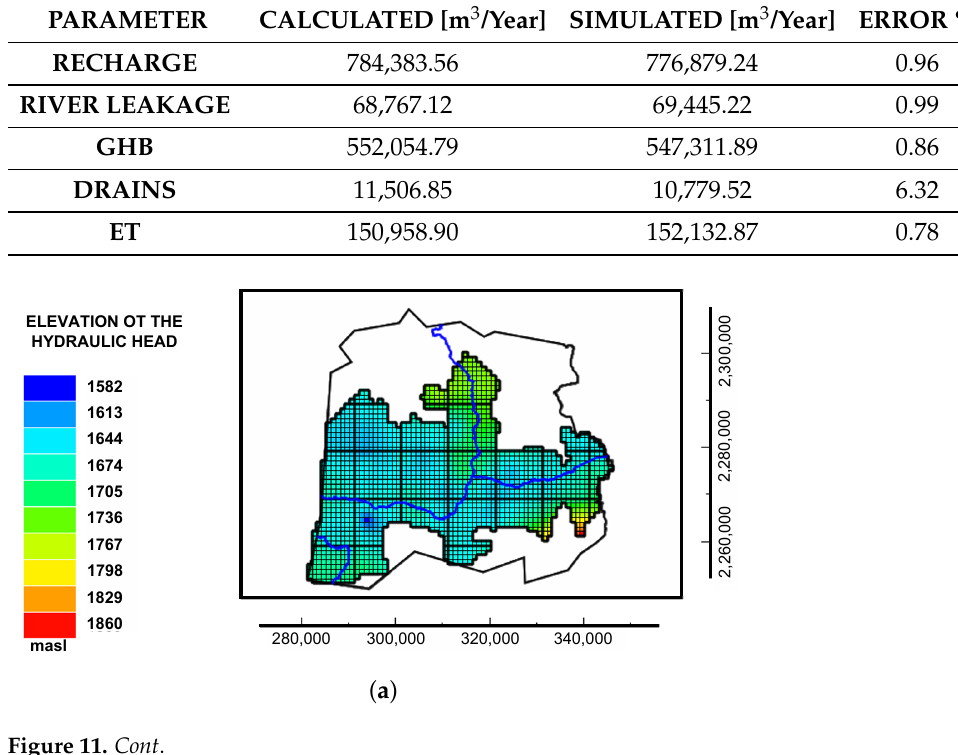
Figura 2.10: Comparaci´on entre las l´ıneas equipotenciales de los niveles piezom´etricos calculados por el modelo (Color Rosa) y los medidos en campo (Color Verde) de la temporada de Lluvias. 61